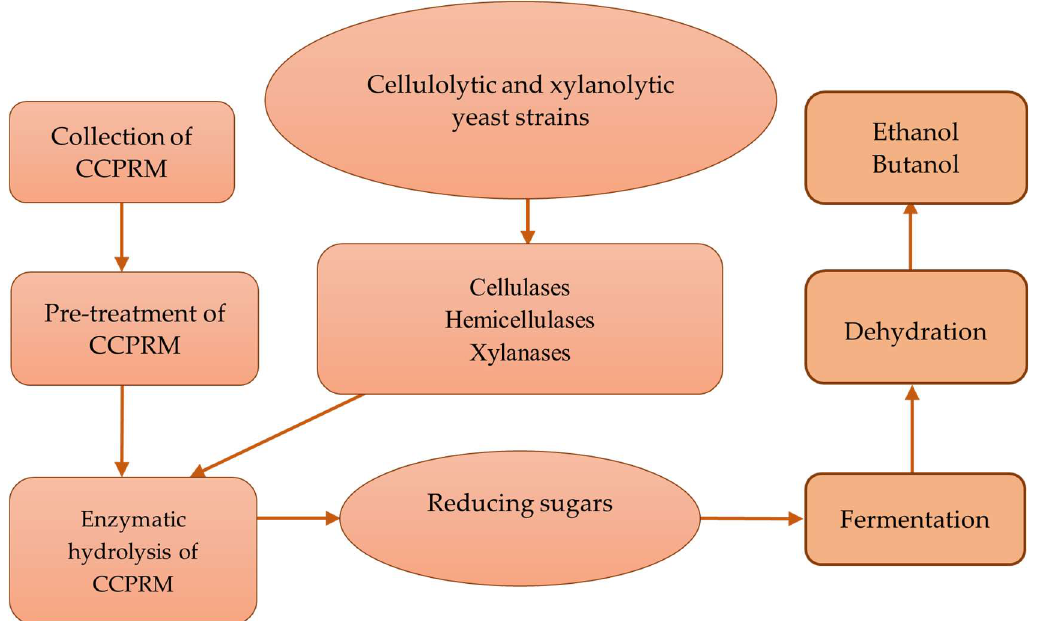
Figure 1. Scheme for producing biofuels from CCPRM using cellulolytic and xylanolytic yeasts. In plant cell walls, hemicellulose is also present in large quantities, along with cellulose. Xylan is the most abundant hemicellulose and is degraded by the activity of xylanases into heterogenous mixtures of sugars. Endo-β-xylanase (EC 3.2.1.8) releases xylooligosaccharides from the xylan backbone; the product of this enzyme is taken up by β-xylosidase (EC 3.2.1.37) to release D-xylose [9,10]. Xylanases also find an array of applications